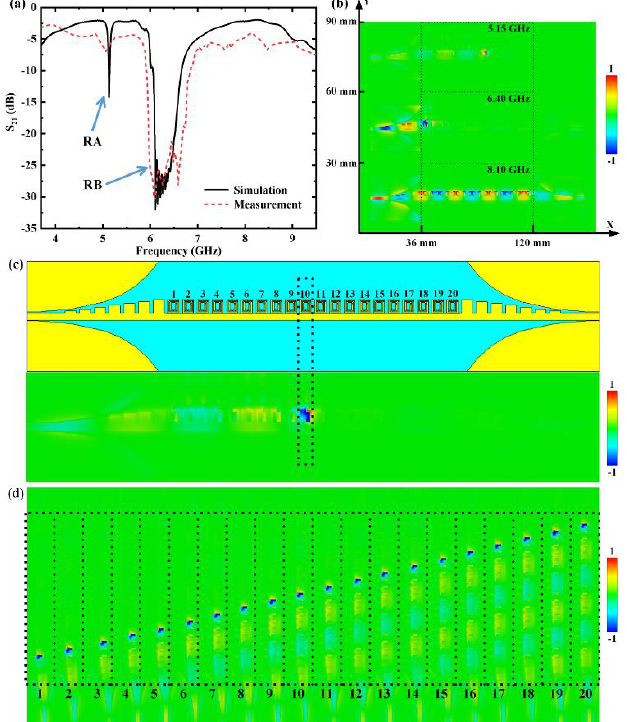
Figure 3. Results of the SSPPs sensor when all the units are divided into two groups. ( a ) The simulated and measured transmission coefficient of the SSPPs sensor. ( b ) The simulated normalized z-component electric field distributions at 5.15 GHz, 6.40 GHz and 8.10 GHz, respectively. ( c ) The simulated normalized z−component electric field distributions of the tunable SSPPs sensor at 5.15 GHz, and where the 10th unit is “1” and other units are “0”. ( d ) The process of electromagnetic waves transmission control with electronic